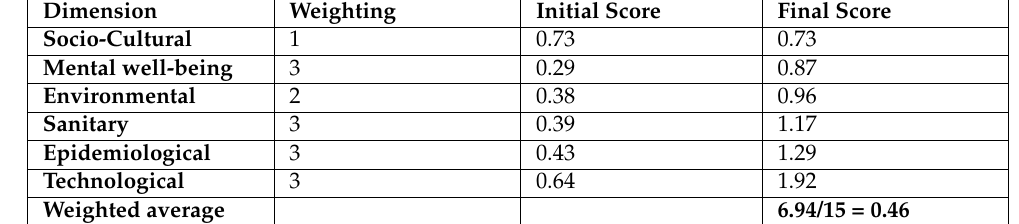
Table 10. Scores and weightings per